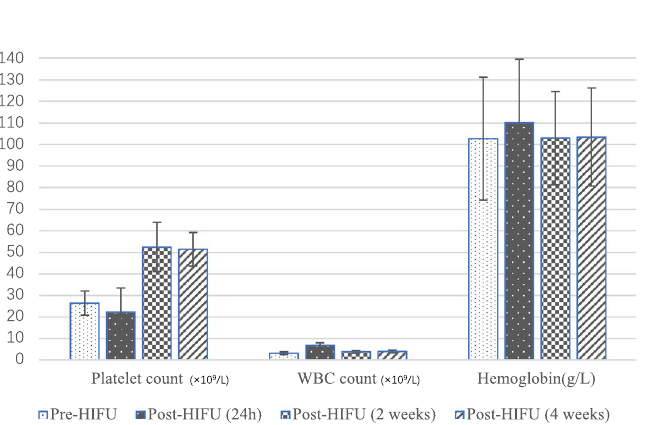
Figure 4. Hematological changes pre-HIFU and post-HIFU.